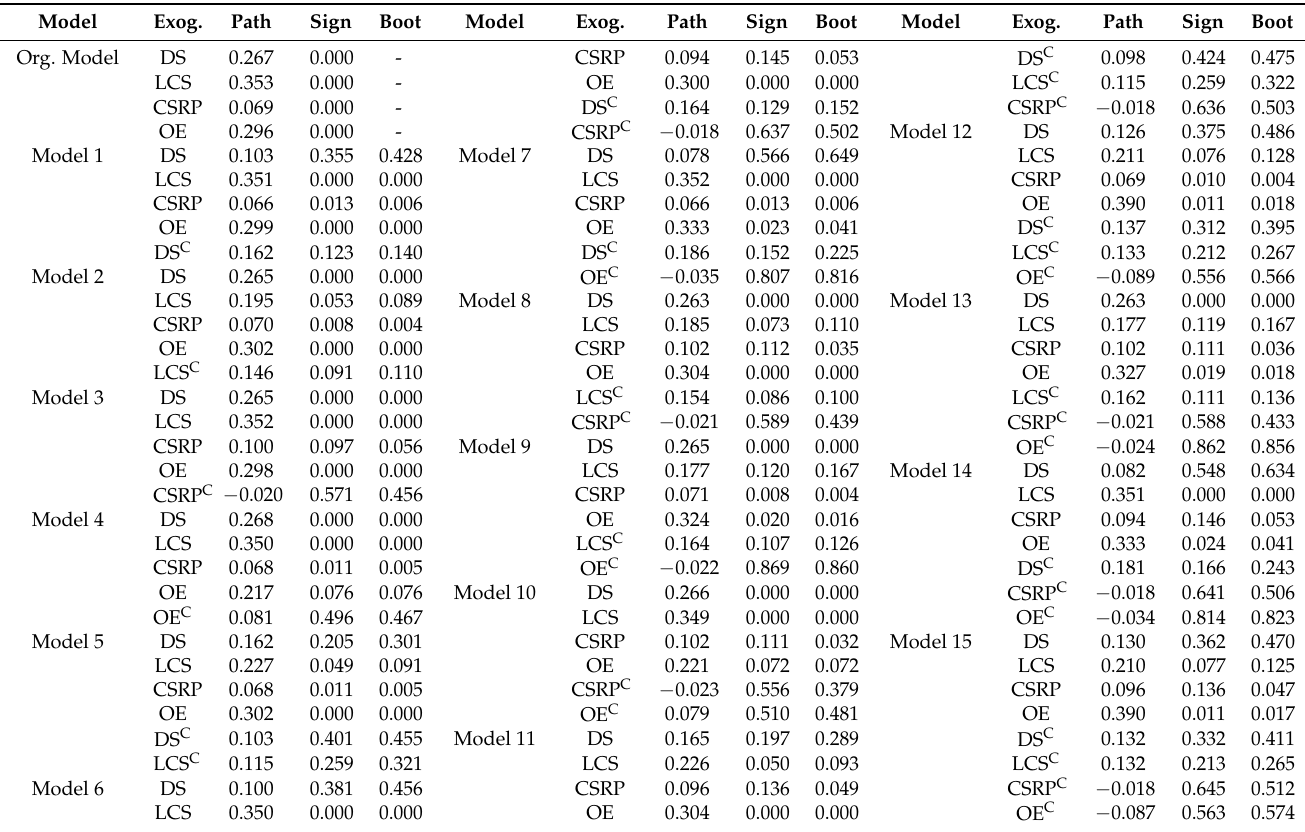
Table 6. Gaussian Copula